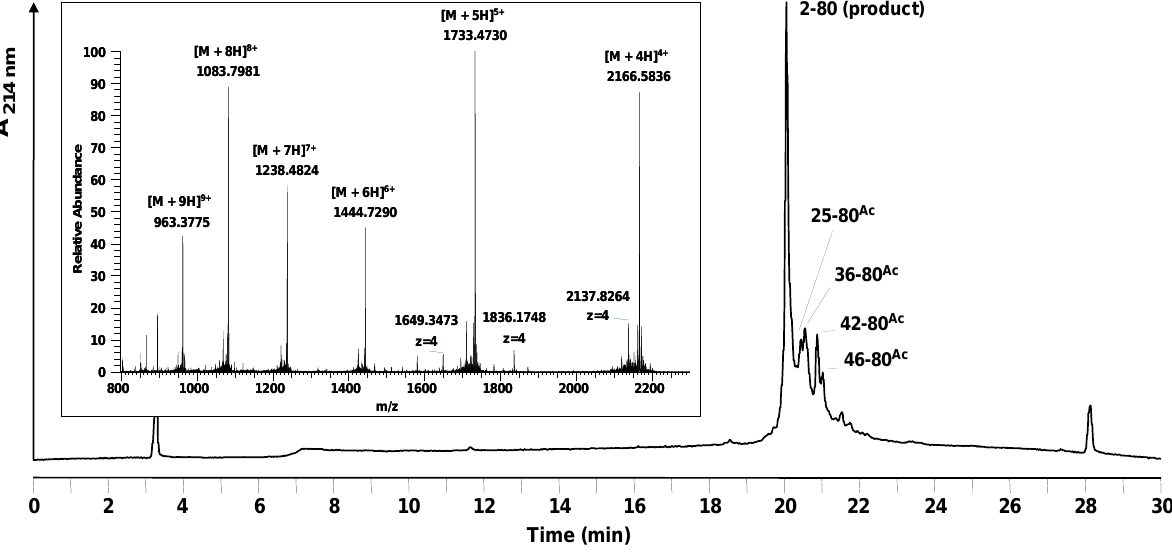
Figure 3. Analytical HPLC and mass spectrometric analysis of the crude peptide after standard stepwise solid phase synthesis at room temperature. The main peak of the HPLC chromatogram corresponds to the desired product. Besides the product, side products were identified by LC-MS. All of the side products are truncated acetylated sequences; their sequences are marked in the chromatogram. Conditions: Hypersil Gold C gradient of 0.1% TFA in water to 0.1% TFA in acetonitrile in 30 minutes, flow rate of 0.2 mL/min, 60 °C, wavelength of 214 nm. Insert: mass spectrum obtained for the main peak (19.9–20.4